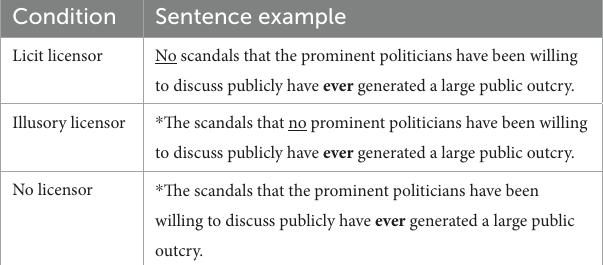
TABLE 2 Three conditions in Experiment 1 and example stimuli (from Xiang et al.,